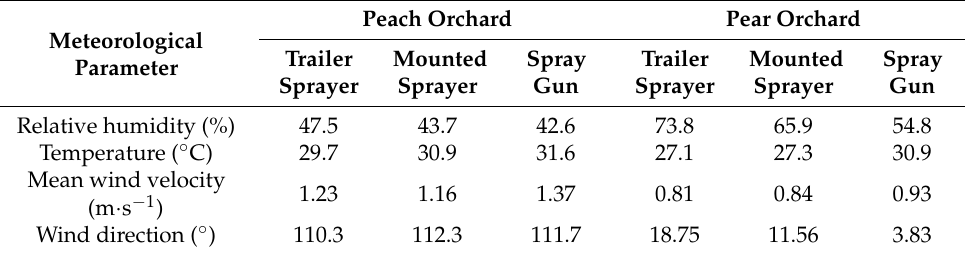
Table 2. Meteorological conditions during spraying in the field test.